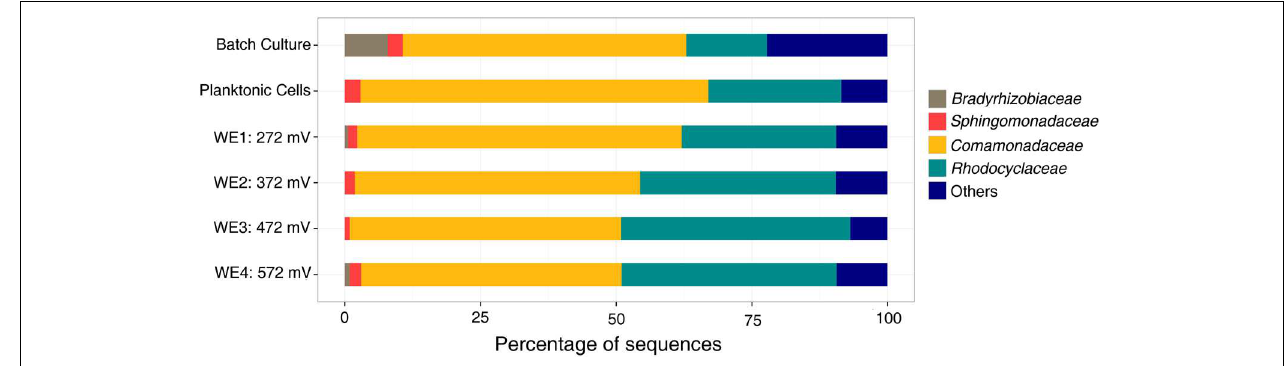
FIGURE 4 | Family level microbial community analysis of the electrochemical enrichment. Families were determined using 16S rRNA tagged pyrosequencing analysis of DNA extracts. A batch culture [acetate as electron donor and Fe(III)-NTA as electron acceptor] was the inoculum for the electrochemical